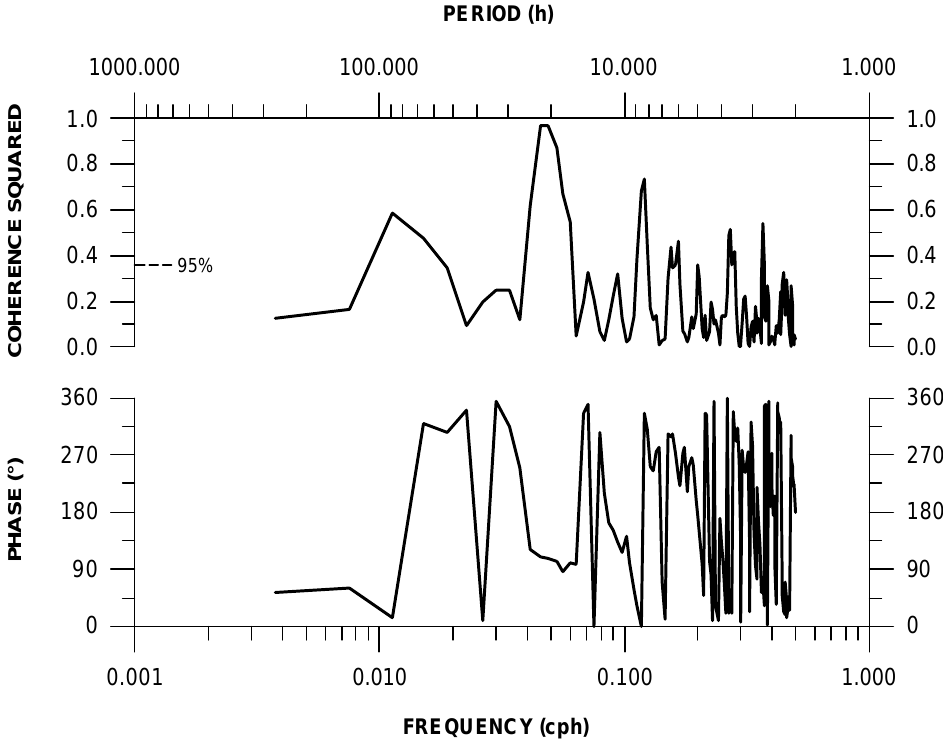
Fig. 9. Coherence squared and phase difference spectra of residual sea levels at Ubli (input) and SW component of residual currents (nominal depth of 20m) at station L-1 (output).